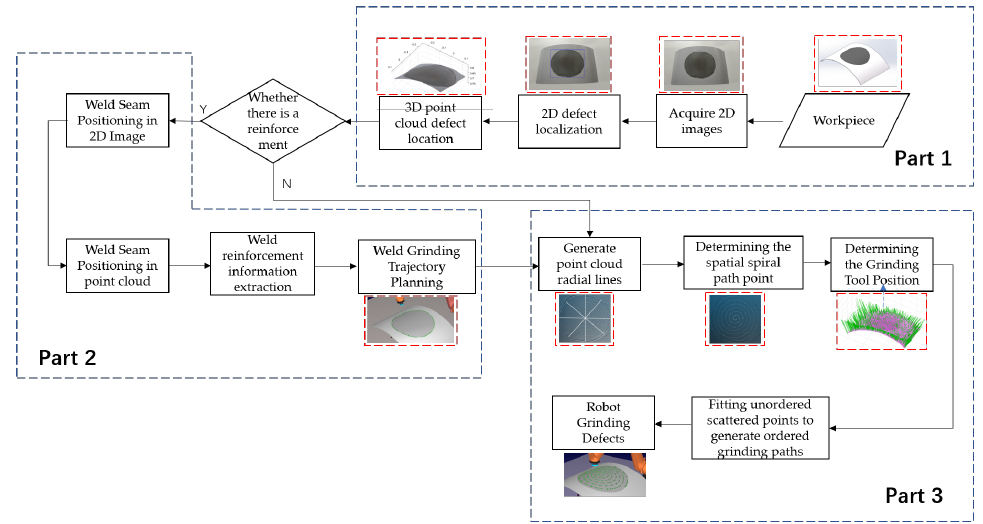
Figure 2. The overall flow of the grinding trajectory planning algorithm.